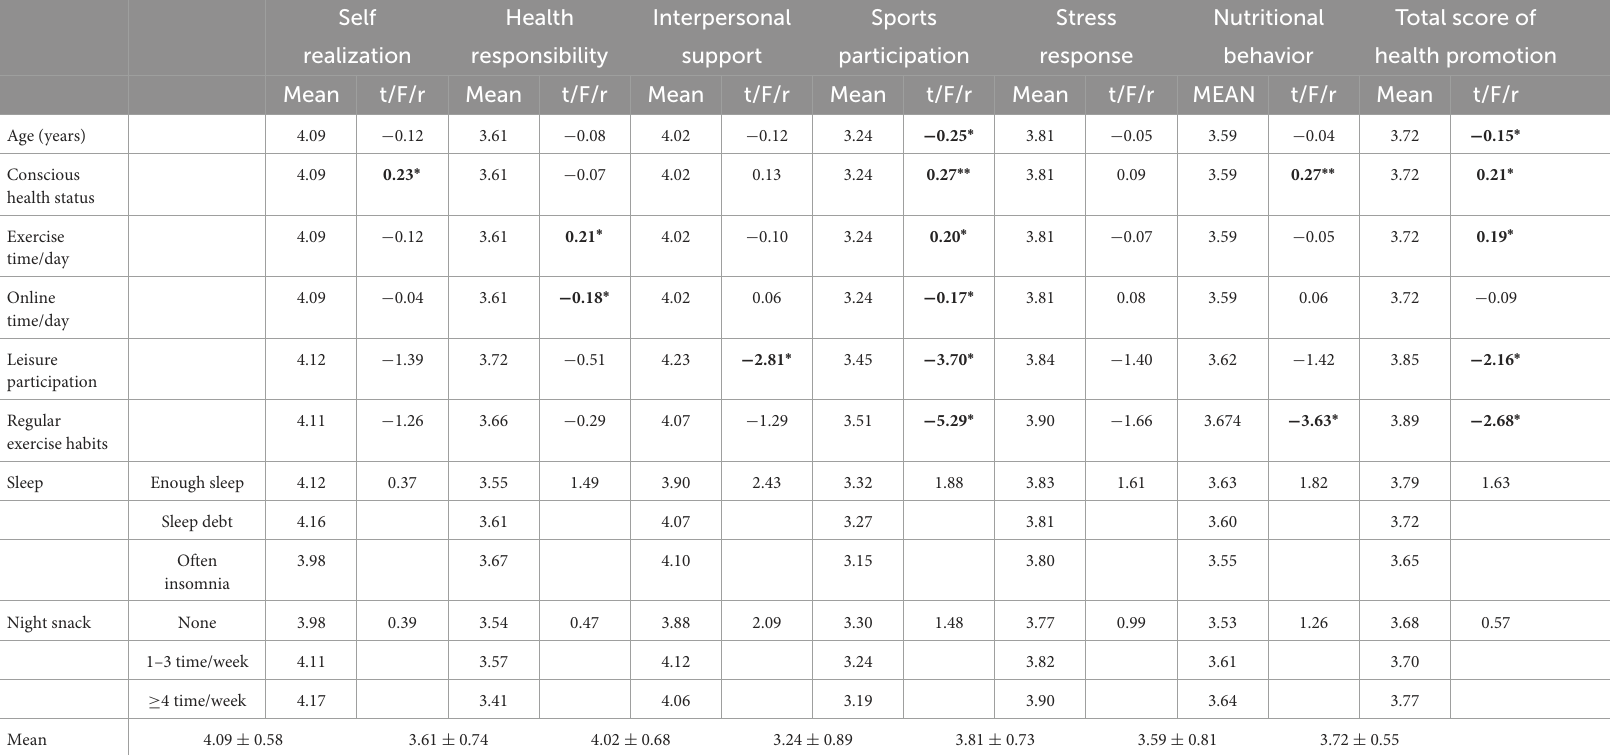
TABLE 3 Statistical table of the influence of College Students’ demographic variables on their health promoting lifestyle. Self Health Interpersonal Sports Stress Nutritional Total score of realization responsibility support participation response behavior health